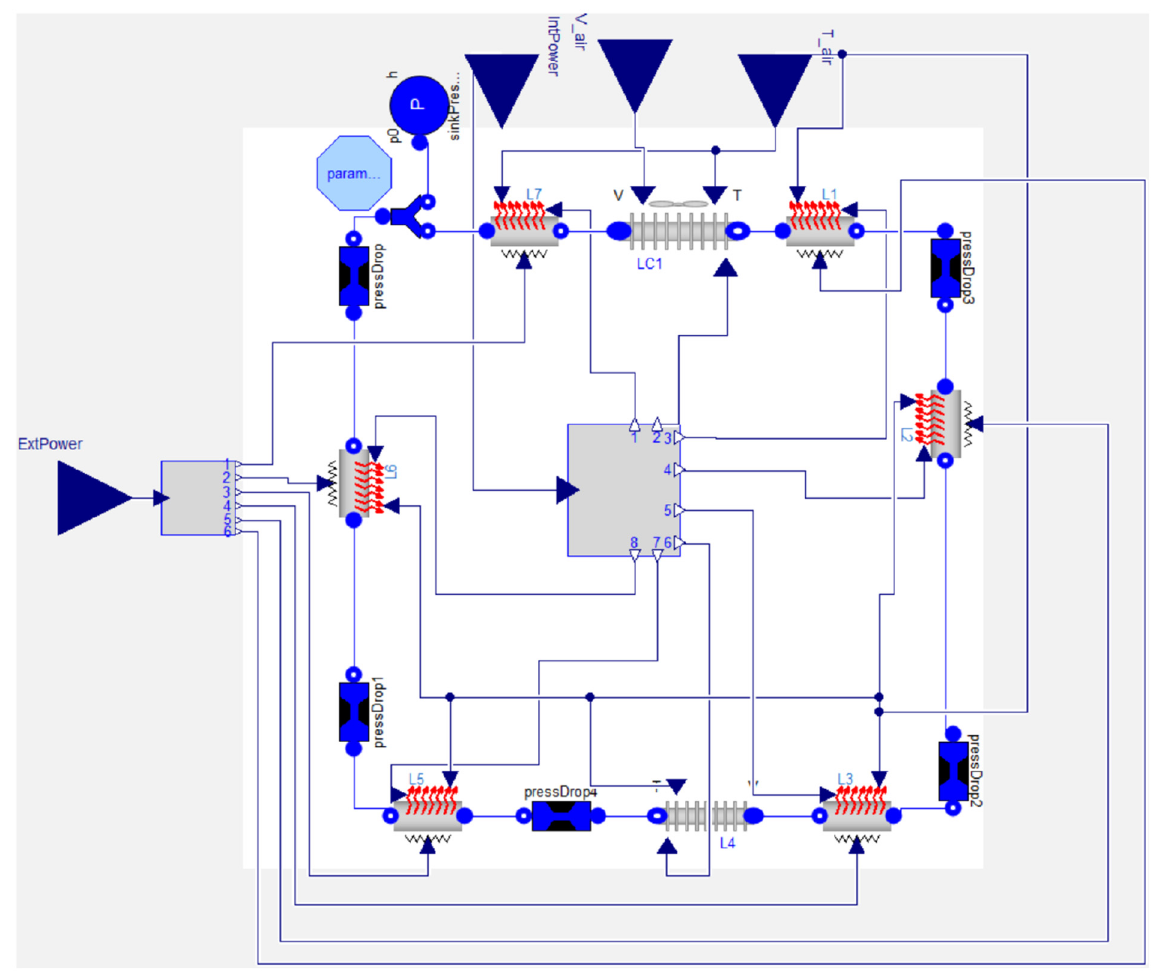
Fig. 7. 1-D model of the facility. Table 7. Simulation wall time for each turbulence